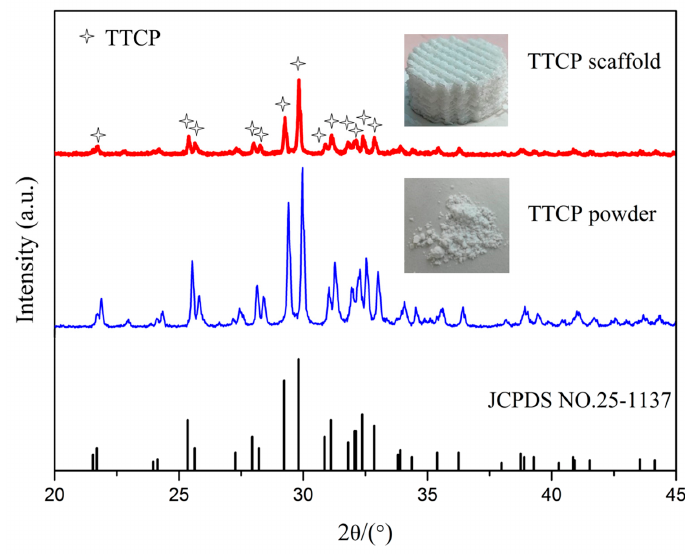
Figure 4. XRD di ff raction patterns of the TTCP powders and the sca ff old fabricated at 9 Figure 4. XRD diffraction patterns of the TTCP powders and the scaffold fabricated at 9 W.